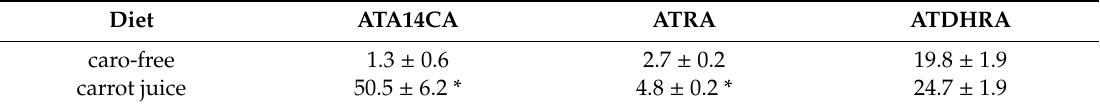
Table 1. Concentrations of retinoids in human serum (each n = 23) after carotenoid free diet for 2 weeks (caro-free) and carrot juice supplementation for two weeks (carrot